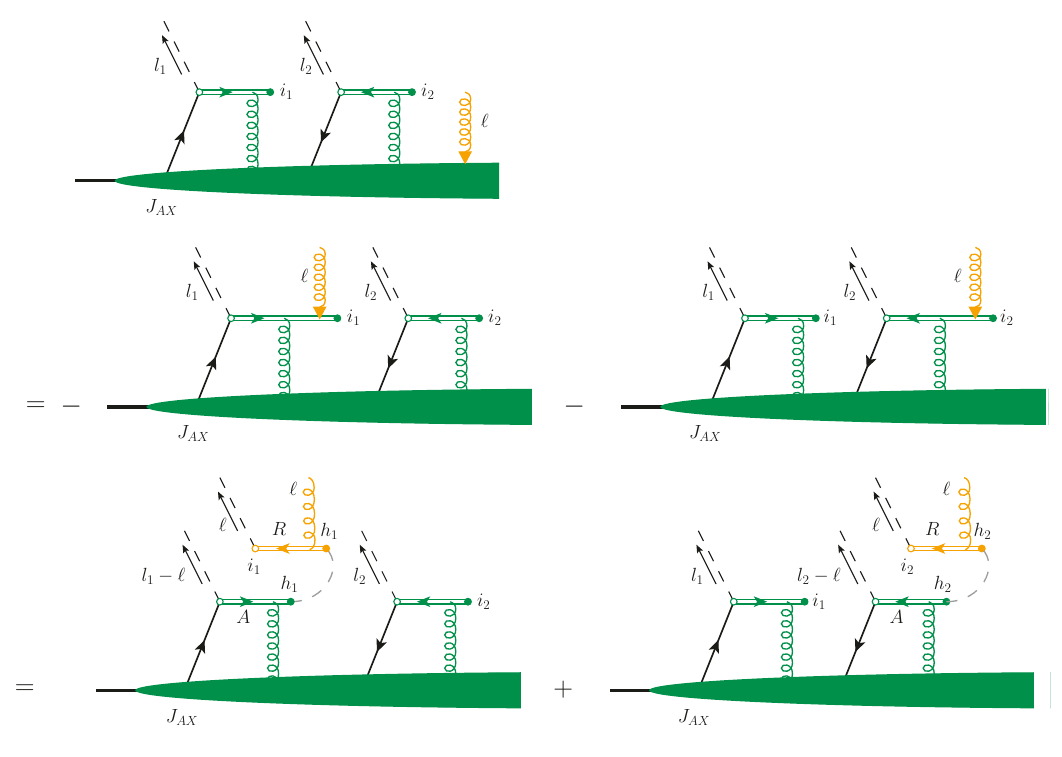
Figure 10 . Decoupling of a single soft gluon from a collinear graph in the amplitude of a DPS